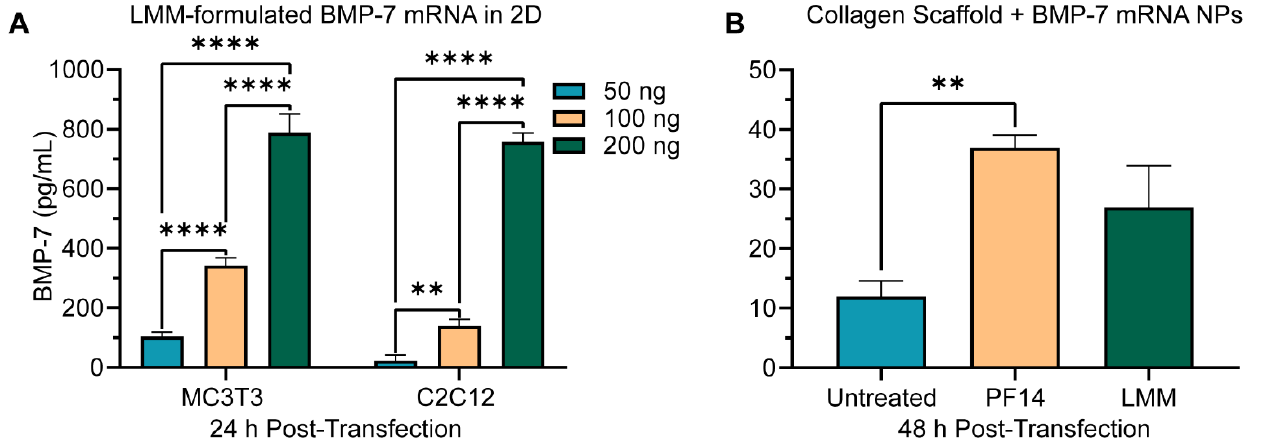
Figure 6. Transfection of cells with BMP-7 mRNA formulations. ( A ) Dose–response function of BMP-7 mRNA transfections with LMM in 2D cell culture. Data represent the mean + SEM of three biological replicates of BMP-7, secreted in the supernatant 24 h post-transfection. ( B ) MC3T3 cells were seeded in collagen scaffolds loaded with 5 µM PF14 BMP-7 mRNA (536 ng mRNA/scaffold) nanoparticles, or LMM formulated mRNAs at equivalent dose. BMP-7 expression was determined by ELISA after enzymatic digestion of the collagen scaffold. Data represent the mean + SEM of two biological replicates of the sequestered BMP-7 protein. **: p ≤ 0.01, ****: p ≤ 0.0001. PF14: PepFect14, LMM: Lipofectamine MessengerMAX.